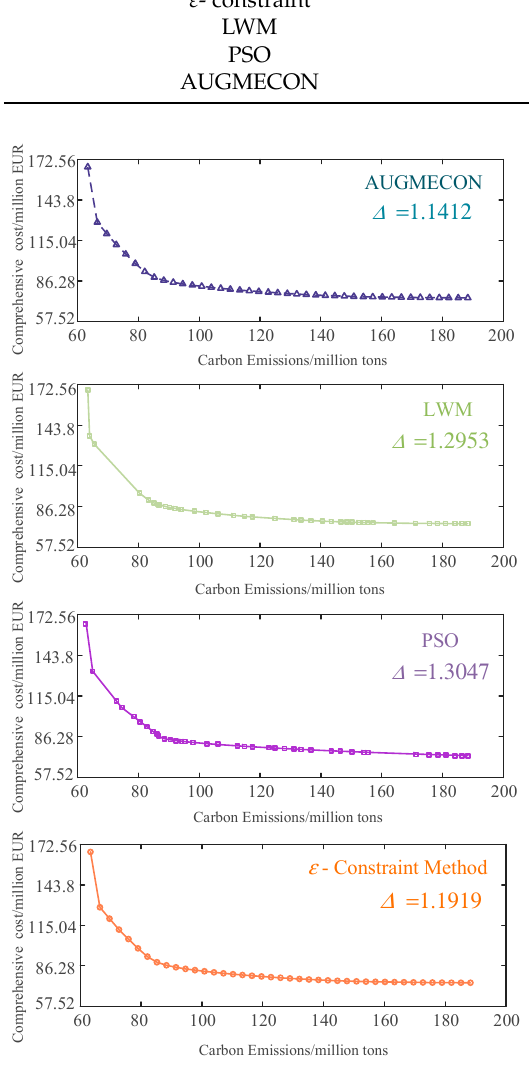
Figure 5. Pareto optimization results by different algorithms.